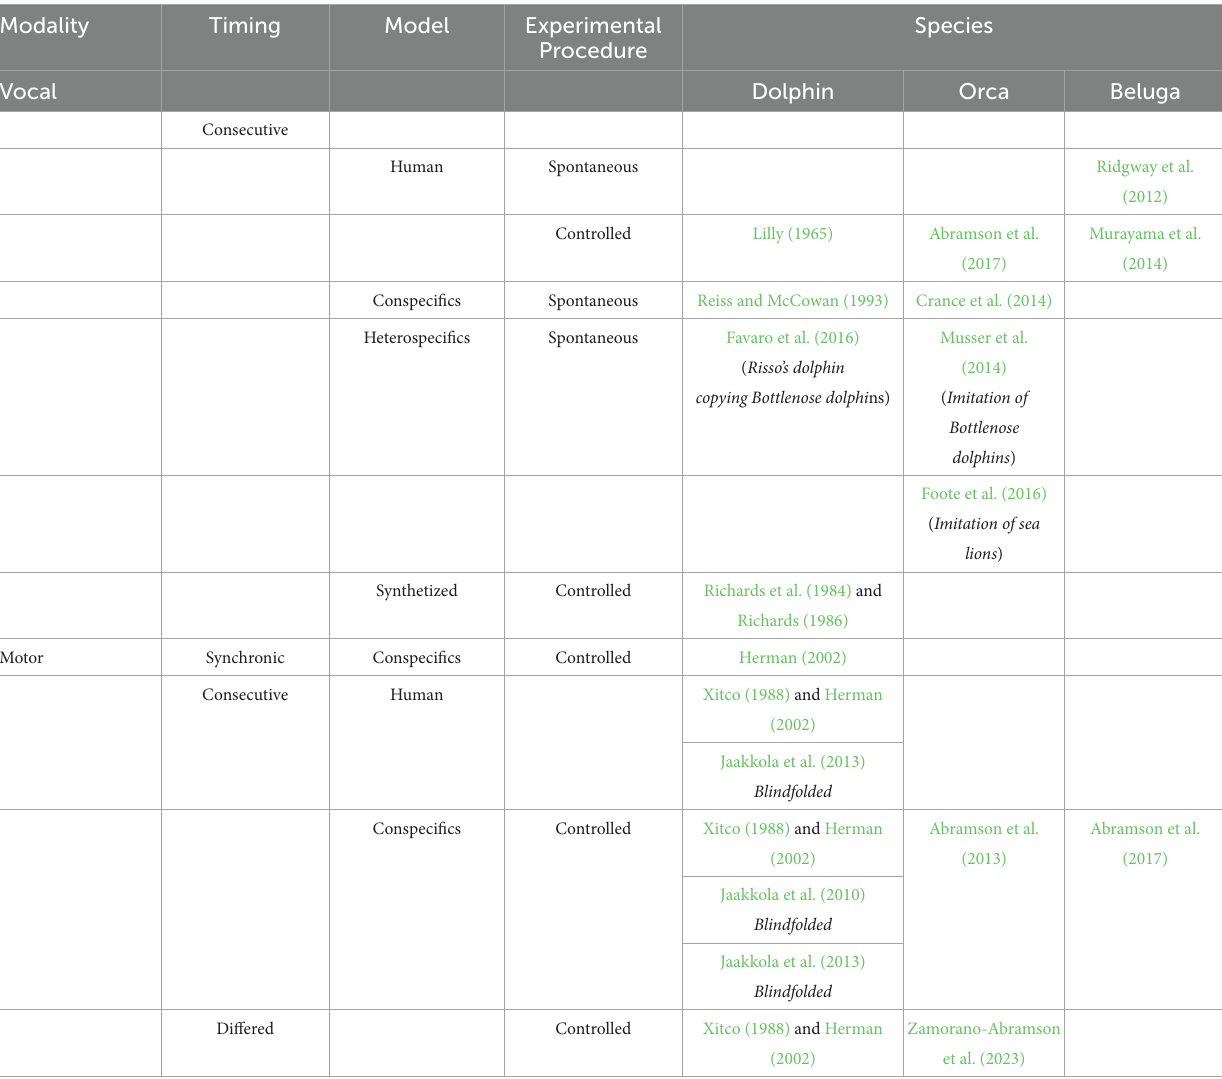
TABLE 1 Summary of the main experimental results on cetacean imitation of novel motor and vocal behaviors and other related complex imitative capacities.